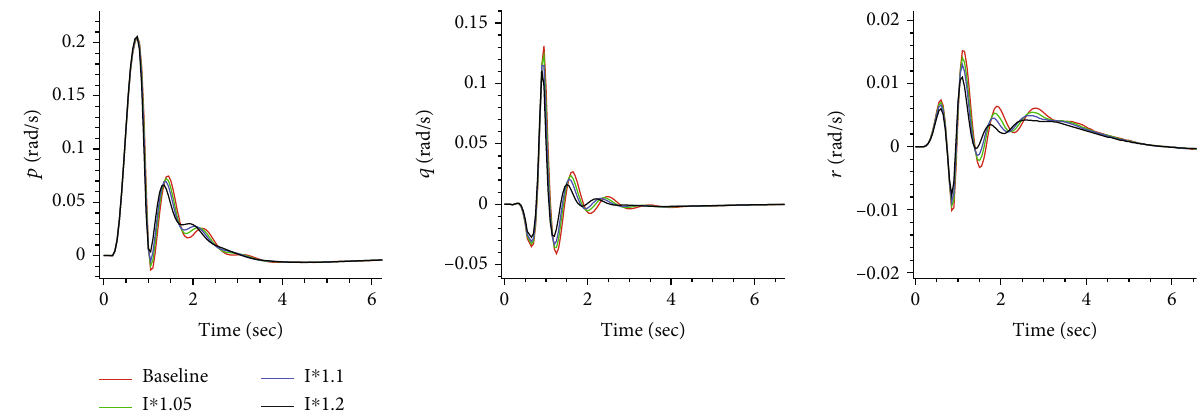
Figure 33: Angular rates of the Quad-Plane with the di ff erent moment of inertia under 5 m/s crosswind.